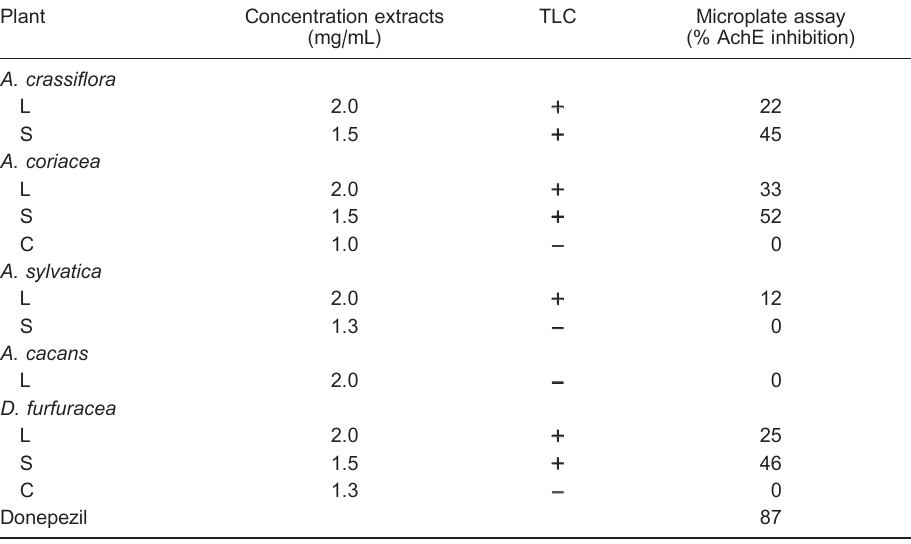
Table 4. Acetylcholinesterase (AchE) inhibition by the methanolic extracts from some Annonaceae plants in the microplate assay (% inhibition) and thin-layer chromatography (TLC).